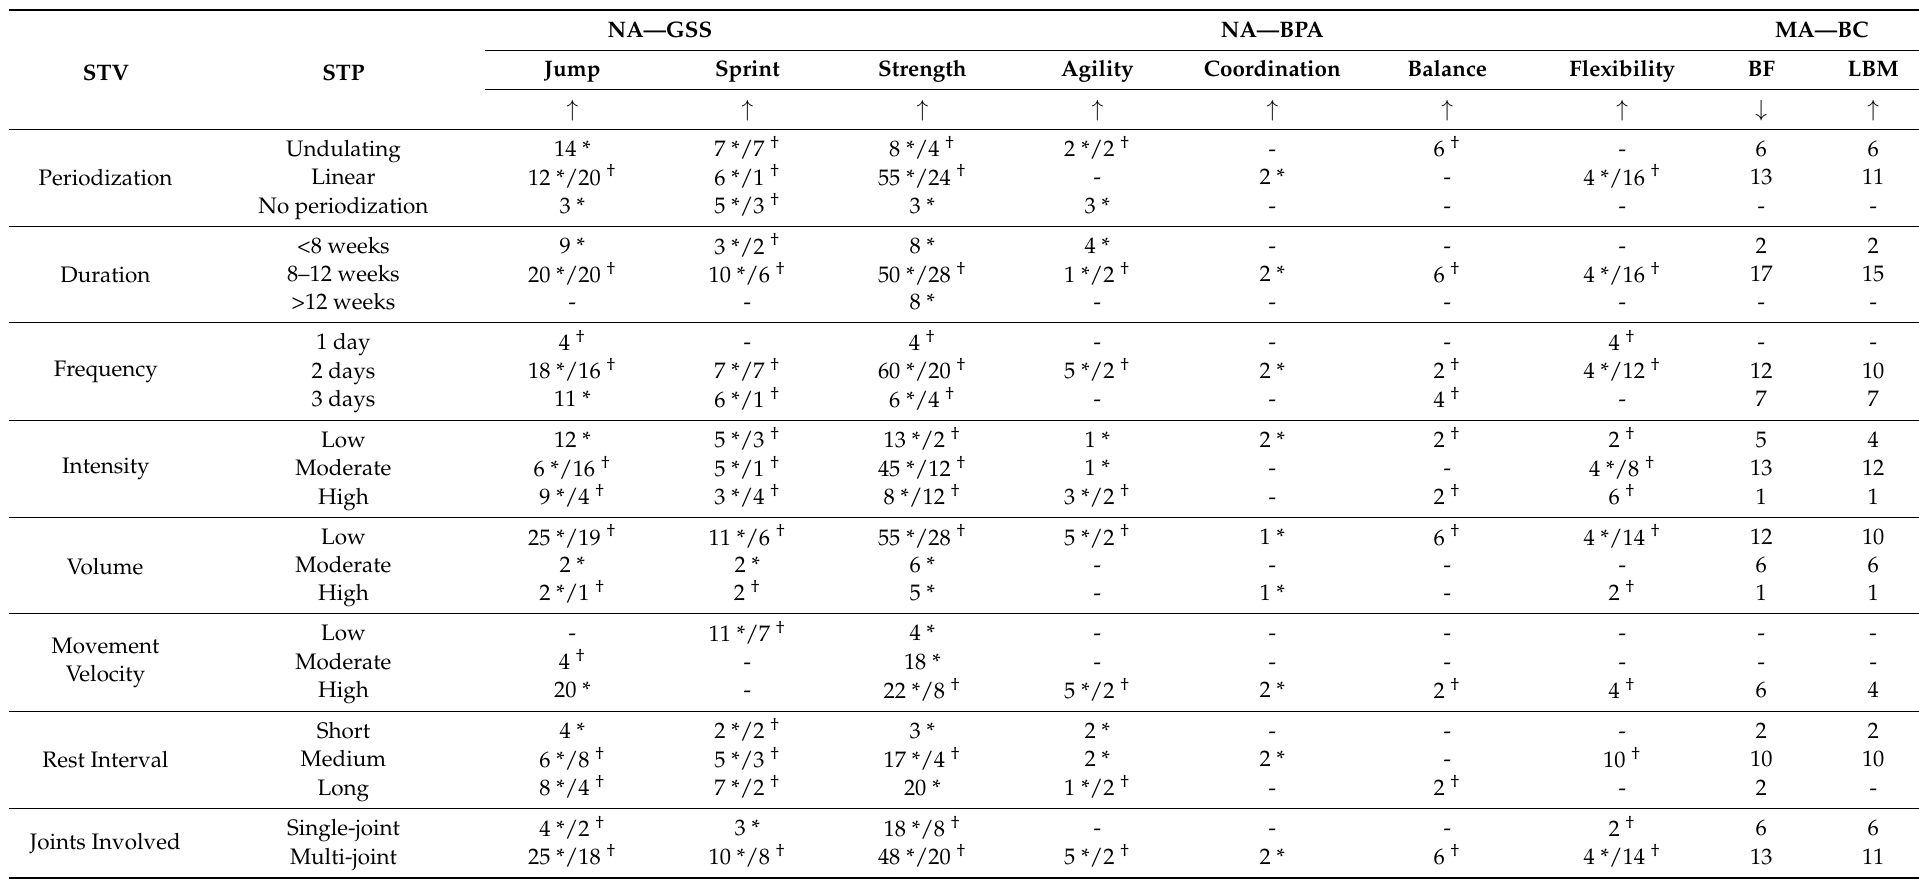
Table 4. Main neuromuscular (NAs) and morphological (MAs) adaptations ( n ) from strength training in prepubertal children (based on the number of